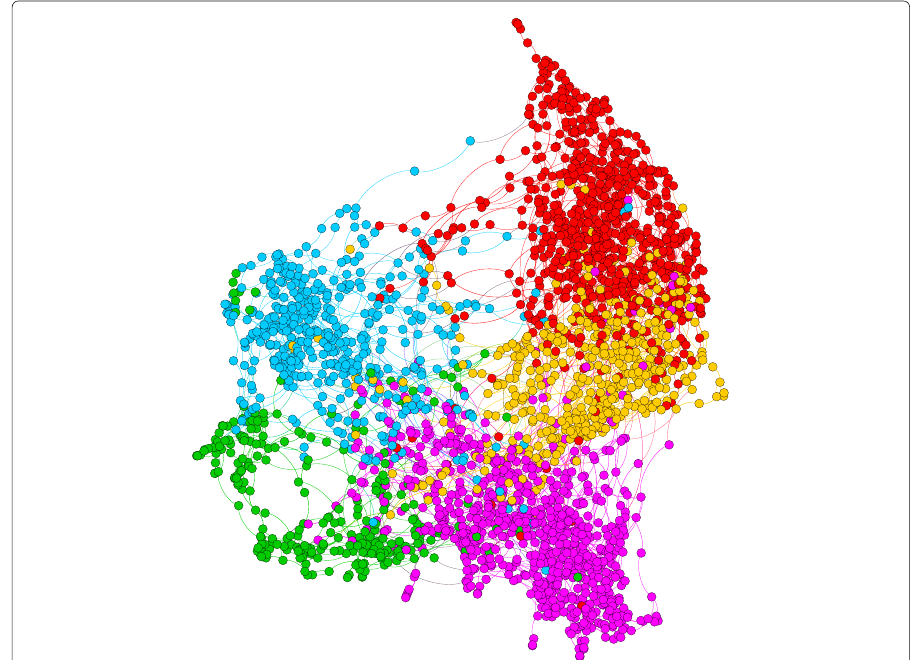
Fig. 2 Visualization of the graph of k = 5 optimal clustering result for kNN3 with Integrity using the correlated filtered set. Red nodes denotes C2, Blue: C4, Gold: C0, Purple: C3, and Green: C1